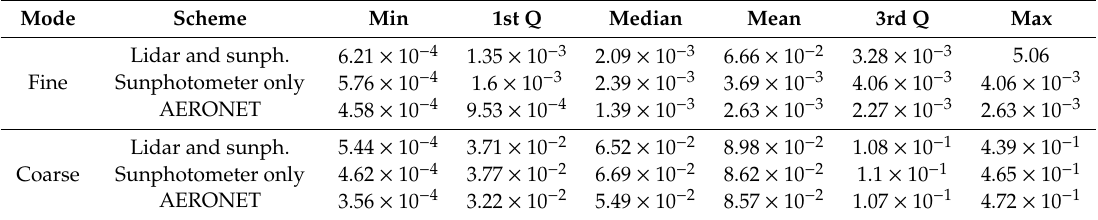
Table 2. Statistical values of volume for the fine and coarse modes of the di ff erent schemes.